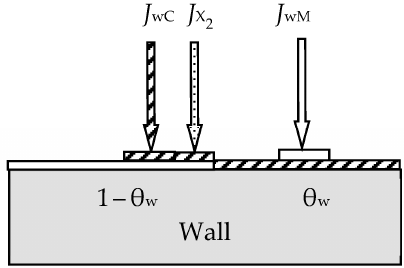
Figure 3. The flux densities on the wall surface. Notations: J wM is the flux density of metal atoms; J w is the flux density of M m X n molecules; θ w is the fraction of the wall surface covered by the compound fi lm.